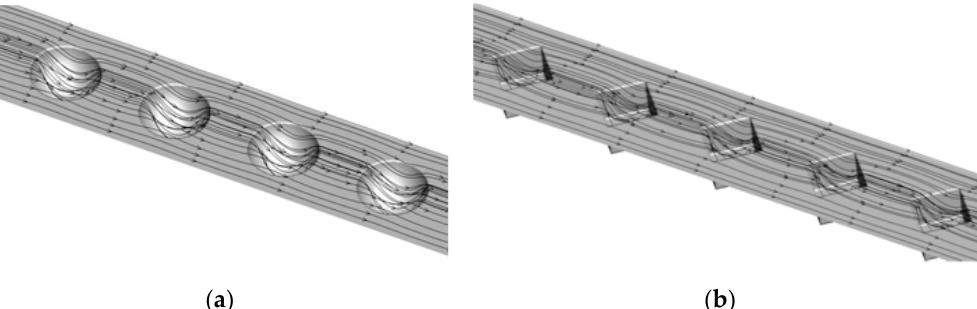
Figure 14. The streamlines in a near-wall channel with a distance of 0.3 mm away from the endwall. ( a ) Hemispherical dimple. ( b ) Rhombus dimple.